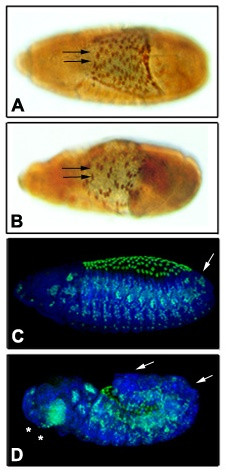
UAS-CG6234IR induction in D. melanogaster embryos. (A and B) Whole-mount immunohistochemical images of embryos (dorsal views) stained with anti-Hnt. (A) A wild-type embryo (stage 12) during germ band retraction. (B) An embryo expressing UAS-CG6234IR induced by nanos-GAL4. Hnt-positive nuclei of amnioserosa cells are indicated by black arrows. (C and D) Immunofluorescence confocal images of embryos (lateral views) stained with anti-Hnt (green) and To-PRO3 (blue). (C) Wild-type (stage 13) showing the amnioserosa nuclei that cover the dorsal region as a result of germ band retraction (white arrow). (D) UAS-CG6234IR ubiquitously expressed under nanos-GAL4 control produces embryos having disrupted germ band retraction (white arrows) and head defects (asterisks).